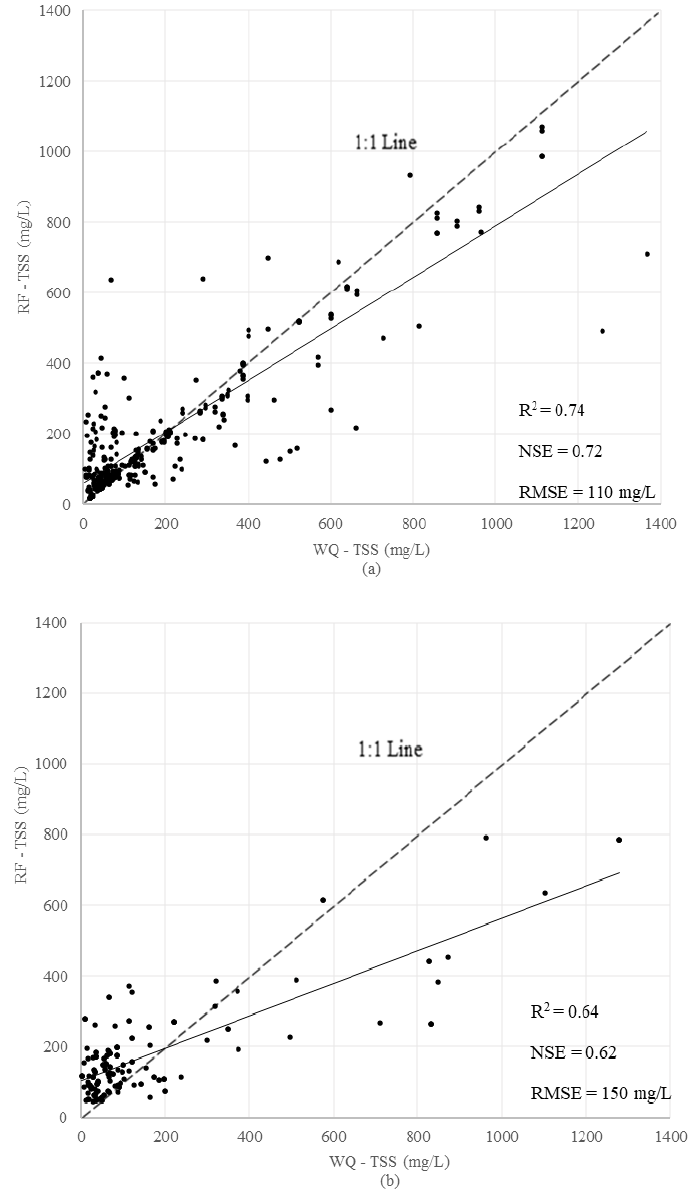
Figure 8. Correlation between the measured values and Random Forest (RF)-predicted TSS con- centration in ( a ) training step and ( b ) prediction